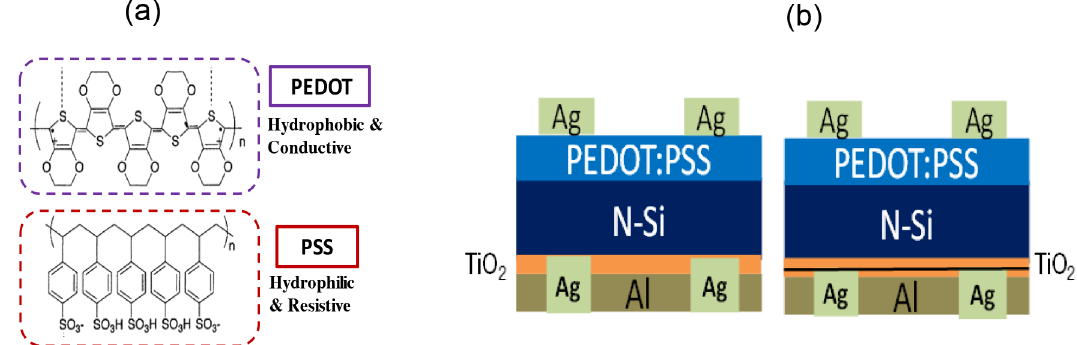
Fig. 1. (a) Molecular structure of PEDOT:PSS, (b) schematic of PEDOT:PSS/n-Si/TiO 2 double heterojunction solar cells with single- and double-TiO 2 layers as